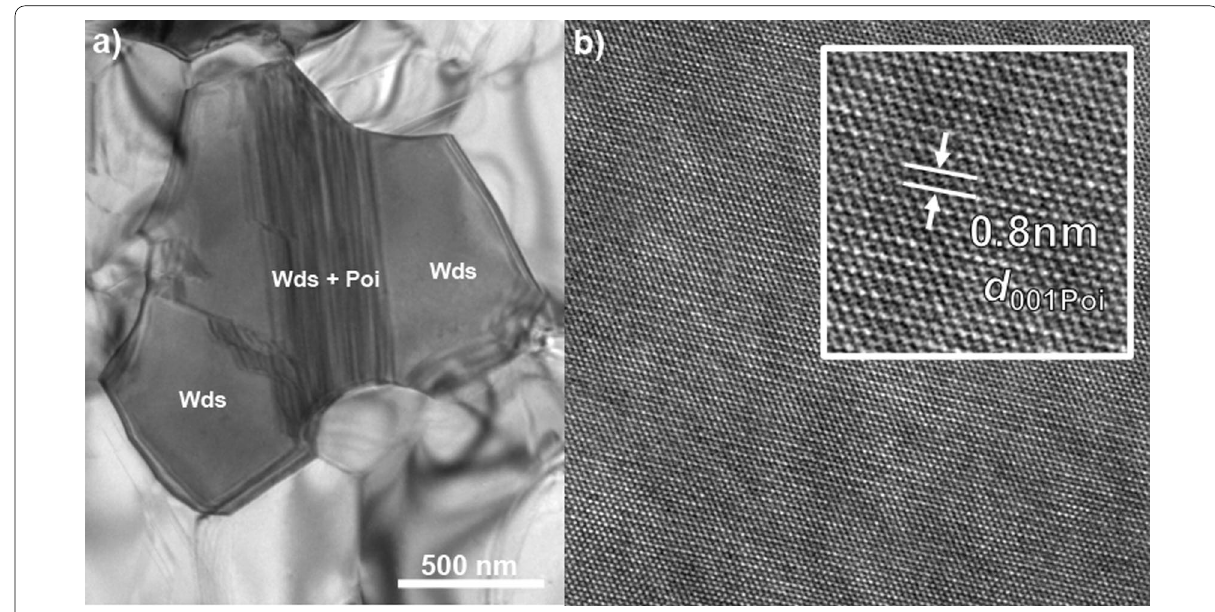
Fig. 5 TEM images of poirierite in the Miami H5 ordinary chondrite. a BF-TEM image of a wadsleyite grain partly replaced by poirierite. b High-resolution (HR) TEM image of poirierite. Lattice fringes with 0.8 nm spacings correspond to d 001 . Wds: wadsleyite, Poi: